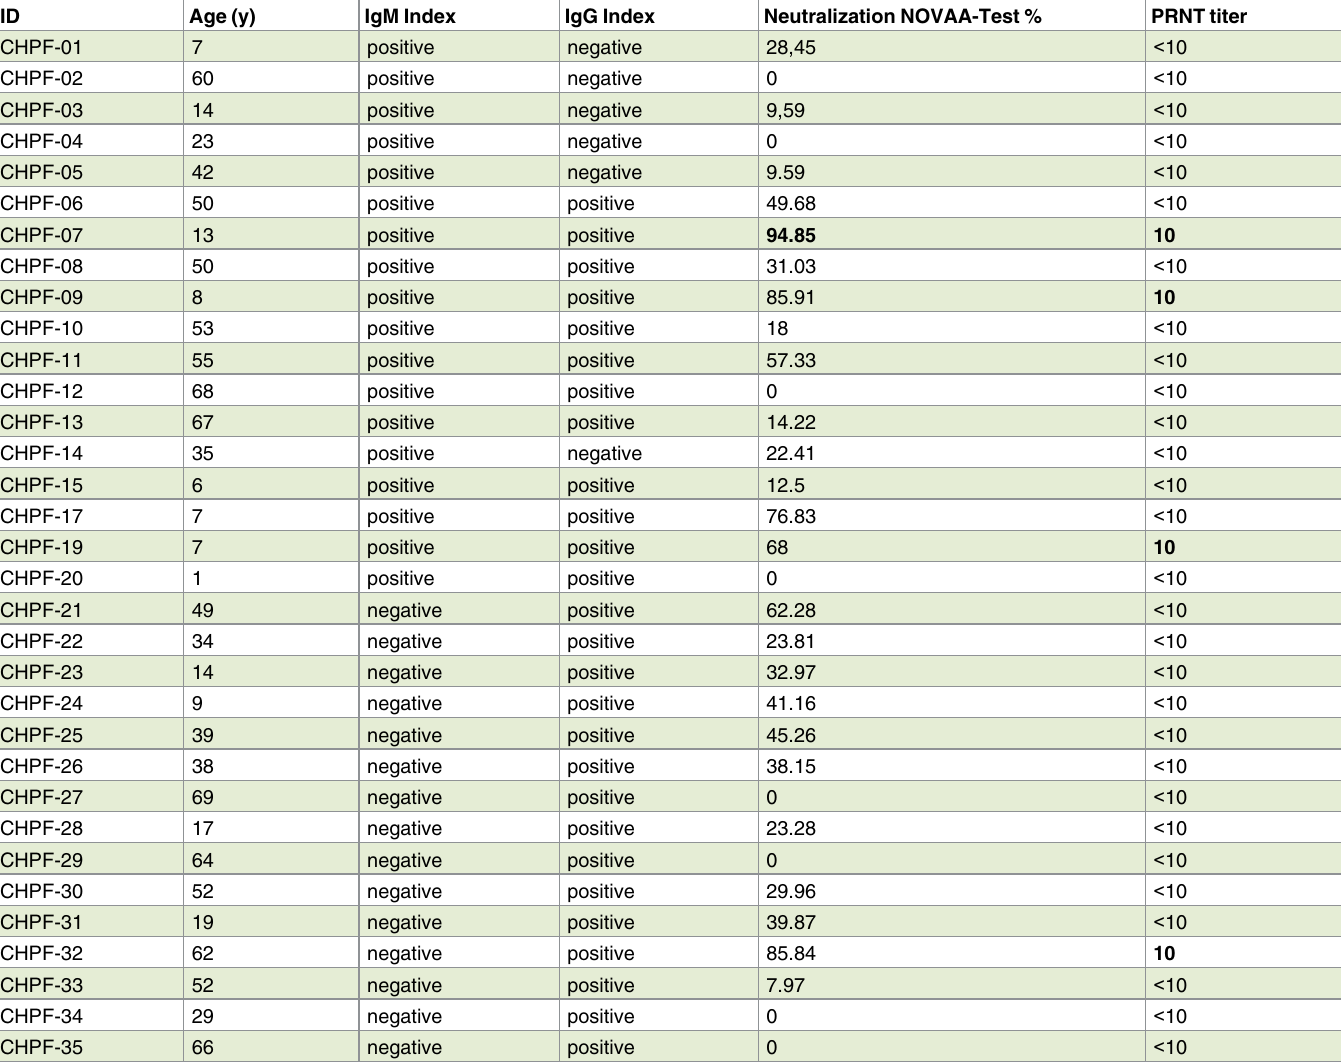
Table 4. NOVAA-test and PRNT in 33 sera collected during acute clinical Dengue from hospitalized Polynesian children and adults